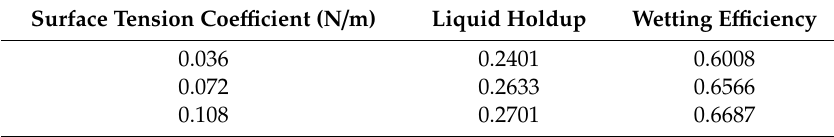
Table 5. Liquid holdup and wetting e ffi ciency of three surface tension coe ffi